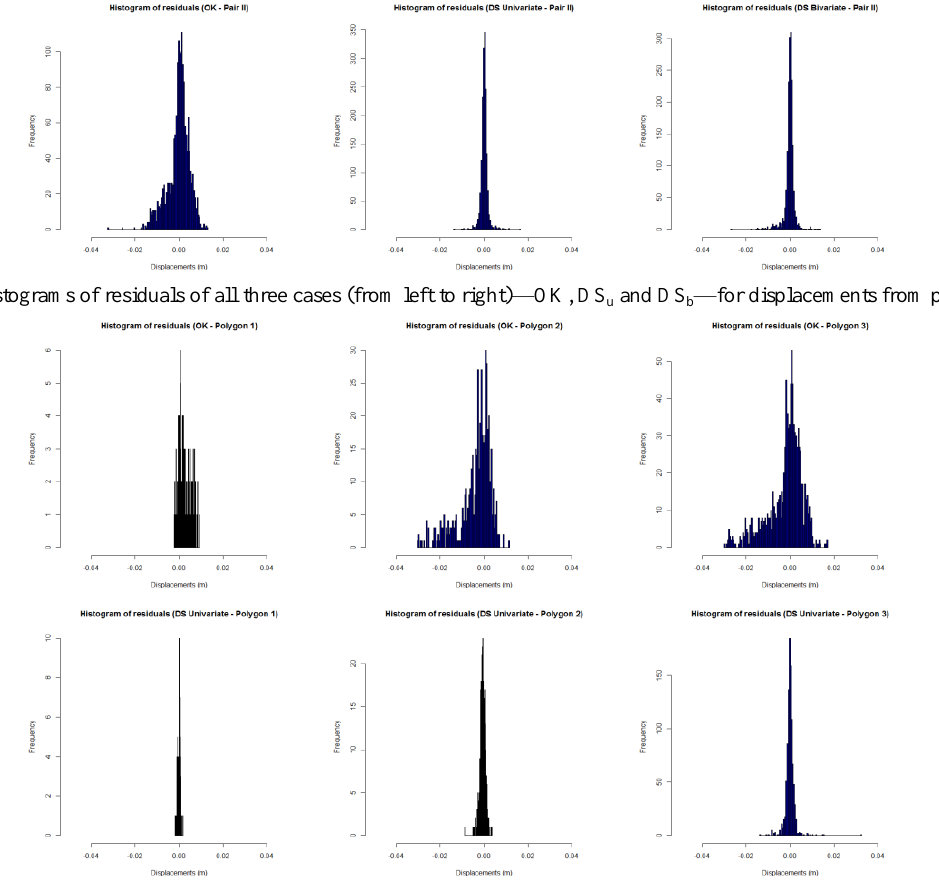
Figure 6. Histograms of residuals of OK and DS u for displacements from pair II. The three columns represent graphs for polygon 1 to polygon 3 (from left to